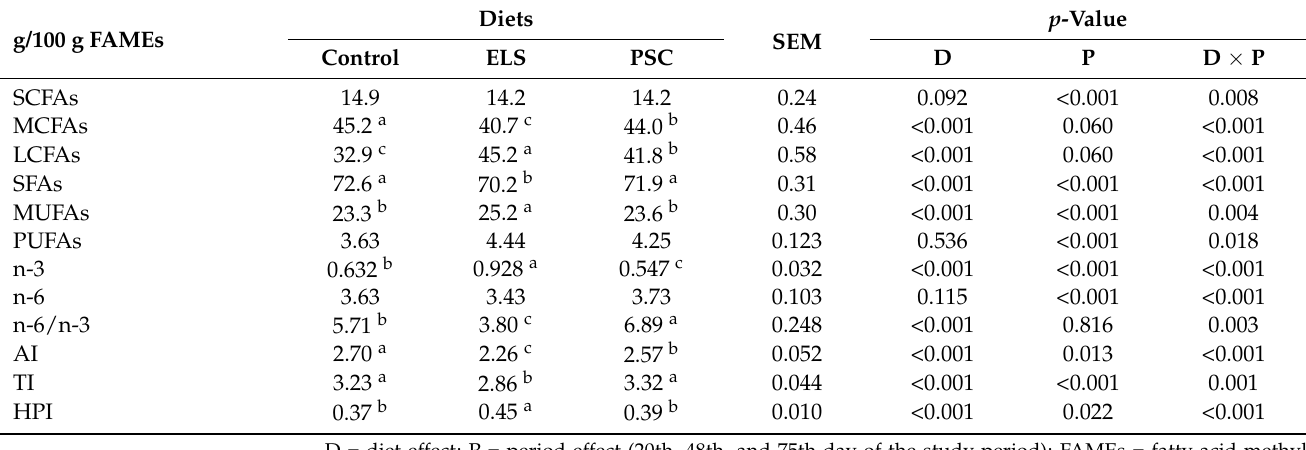
Table 4. Mean values of groups of fatty acid proportions (g/100 g fatty acids) in semi-hard cheese of goats fed with diets containing extruded linseed (ELS) or pumpkin seed cake (PSC).